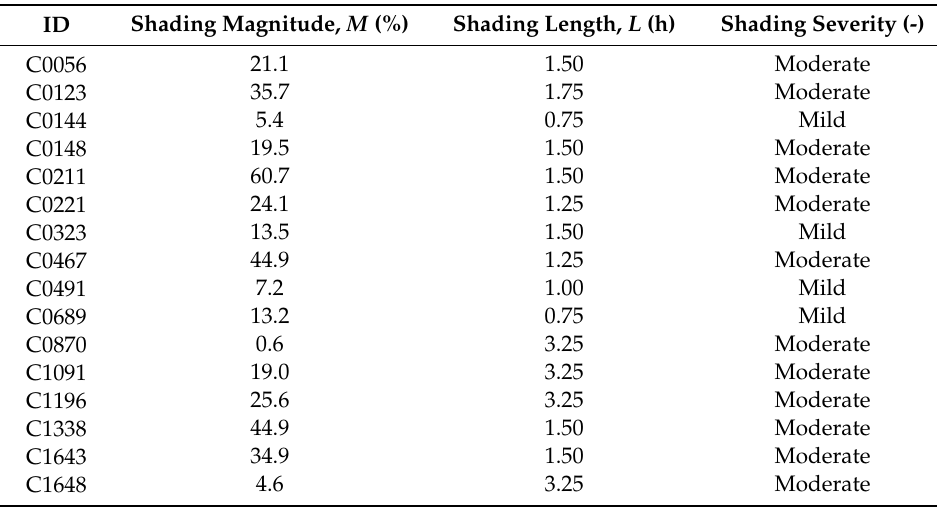
Table 4. Photovoltaic (PV) systems correctly detected with daytime shading under adverse weather conditions, and their respective shading magnitude, shading length and shading severity.